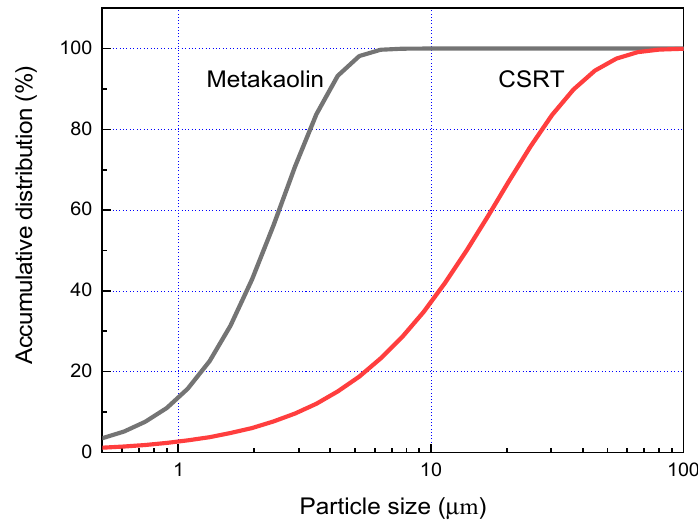
Figure 1. Size distribution of the tailings and metakaolin samples.